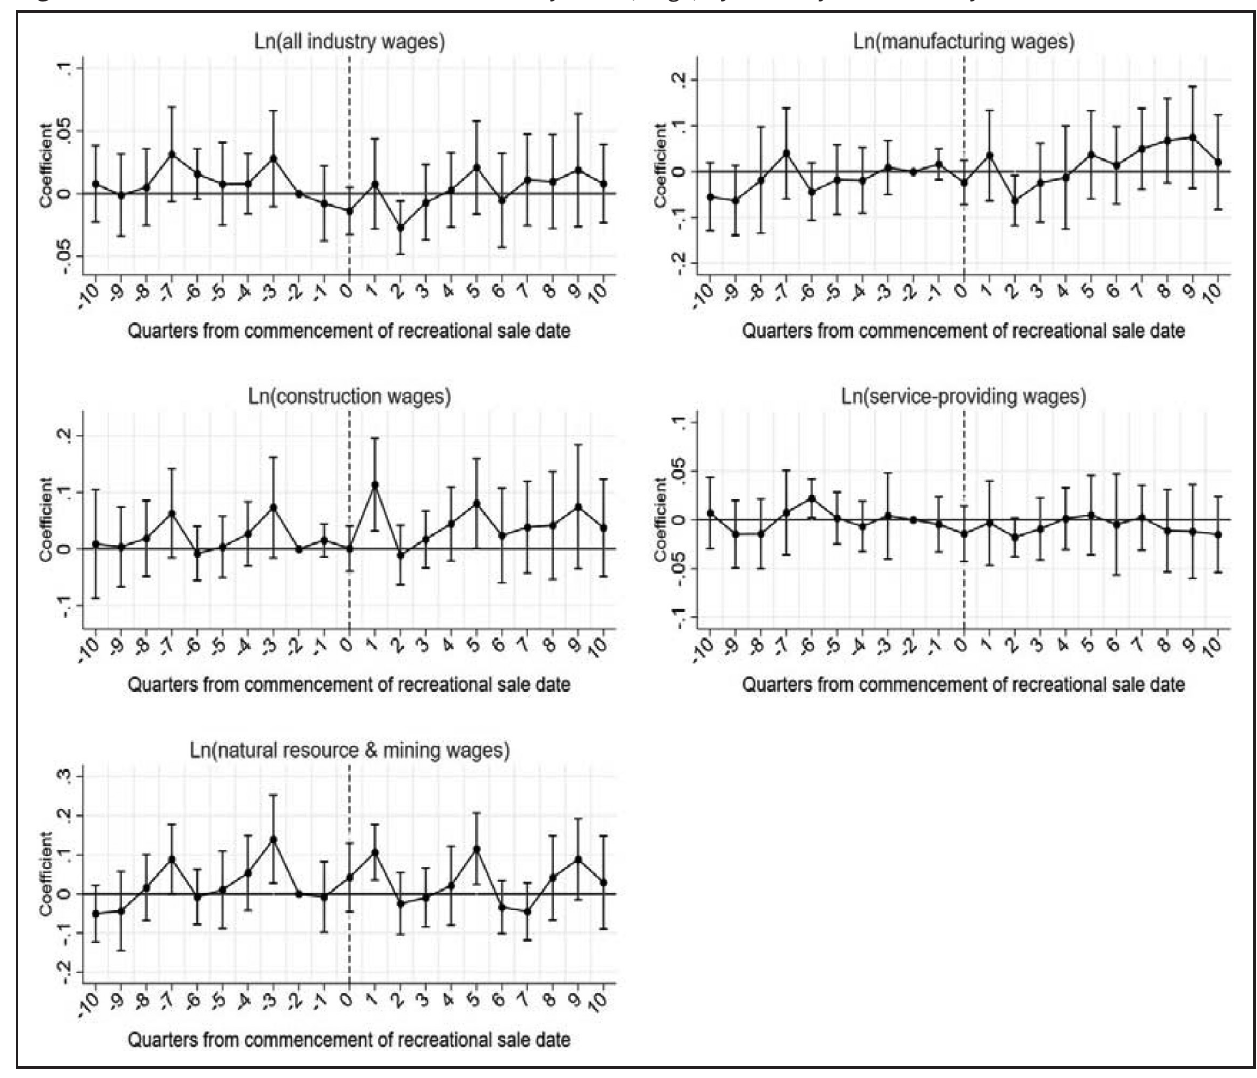
Figure A11 Effect of recreational cannabis entry on Ln(wage) by industry – event